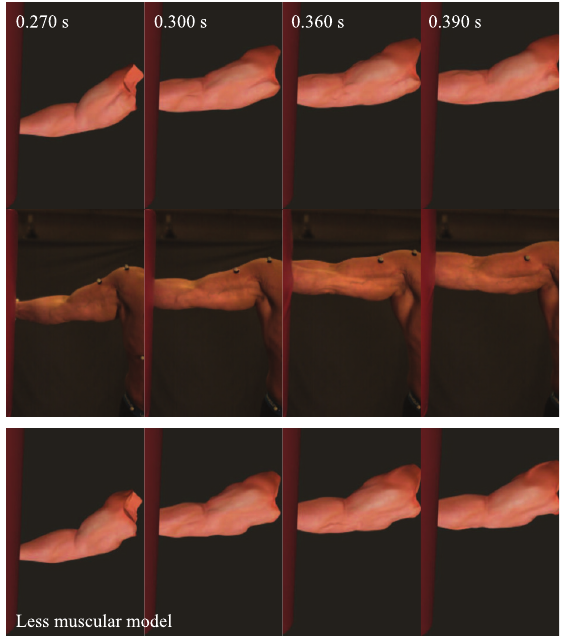
Fig. 8 Skin deformation simulation of an arm with an external impact. The bottom row shows a simulation result with a less muscular